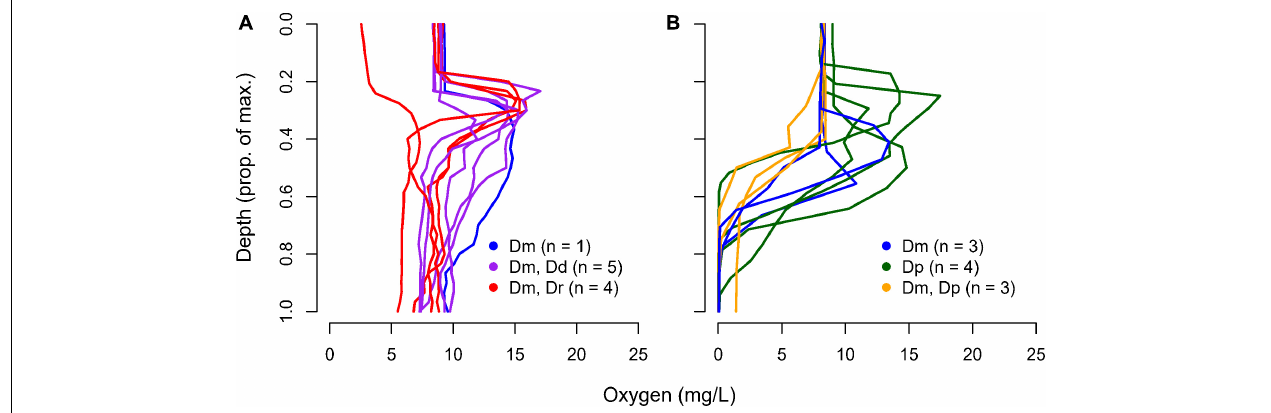
FIGURE 1 | Oxygen-depth profile and Daphnia species occurrence in 20 Frontenac Arch lakes. Lakes are divided into those with (A) normoxic or (B) hypoxic conditions at the bottom of the water column. Species found were D. pulicaria (Dp), D. mendotae (Dm), D. dubia (Dd), and D. retrocurva (Dr). The identity of the specific lakes with different Daphnia compositions can be found in Supplementary Materials